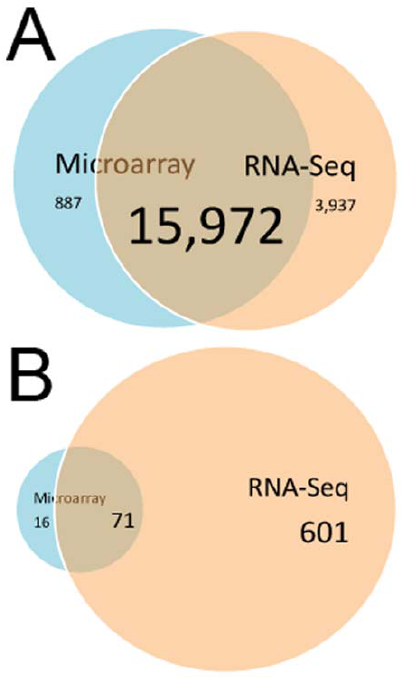
Figure 3. Comparison of Microarray and RNA-seq platforms. To compare data from the Microarray and RNA-Seq platforms, data from Genesprings (microarray) and DuffDiff (RNA-seq) were imported into Ingenuity Pathway Analysis Software. (A) Comparison of total gene expression in microarray and RNA-seq. For the microarray, the number of genes present after filtering for probe intensity between the 20 th and 100 th percentiles is shown in blue. The total number of reads aligned to the reference genome (FPKM . 0) from the RNA-seq experiment is shown in pink. Most of the genes that are expressed overlap in both platforms; however, RNA-seq detected an overall larger number of expressed genes relative to the microarray (B) Comparison of regulated genes in microarray and RNA-seq experiments. All of the genes that were regulated up or down 2-fold, p , 0.05 in the microarray are shown in blue. Genes that were determined to be regulated up or down 2-fold, q , 0.05 in the RNA-seq experiment are shown in pink.